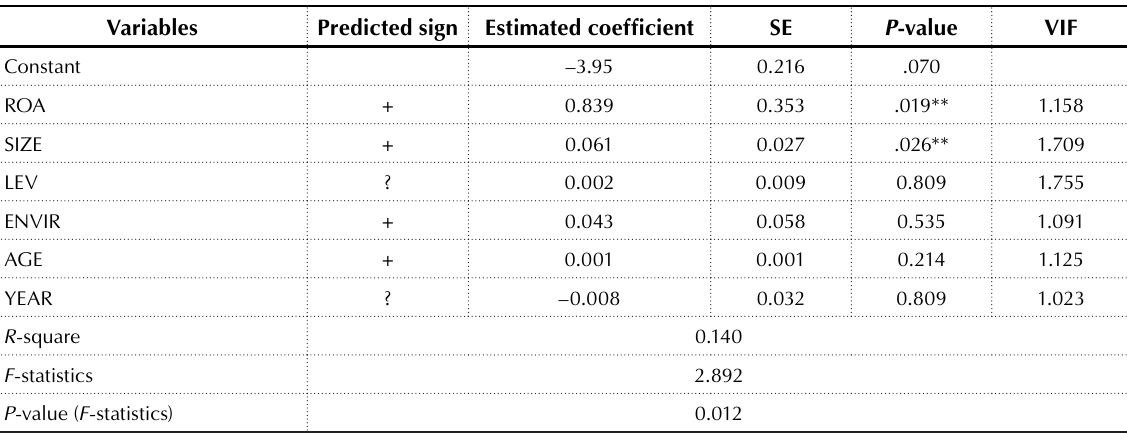
Table 5. Regression